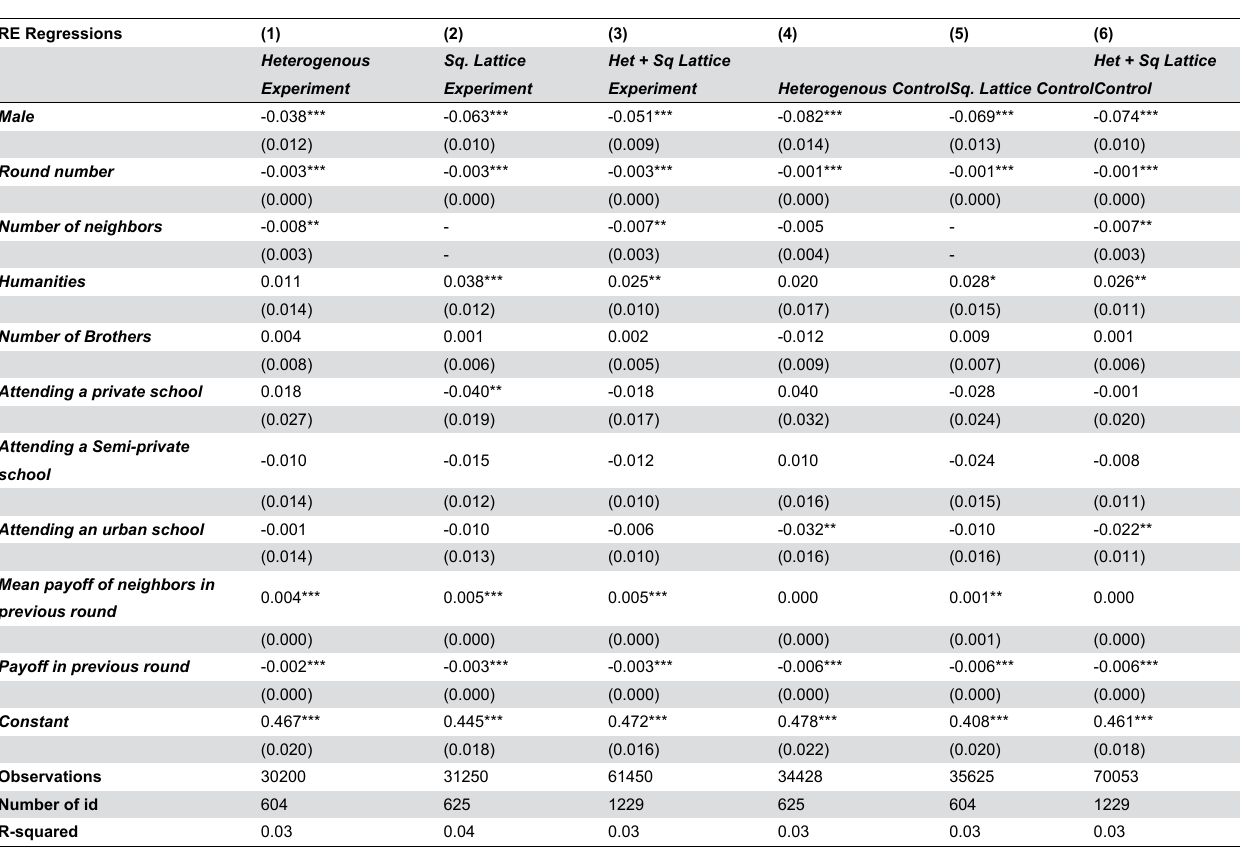
Table 3. Random effects regressions for cooperation of individuals playing the Prisoner’s Dilemma.